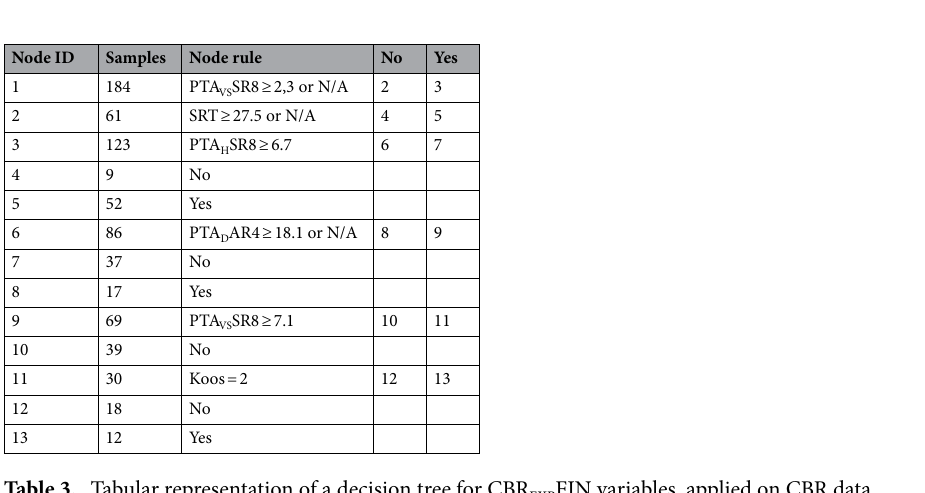
Table 3. Tabular representation of a decision tree for CBR EXP FIN variables, applied on CBR